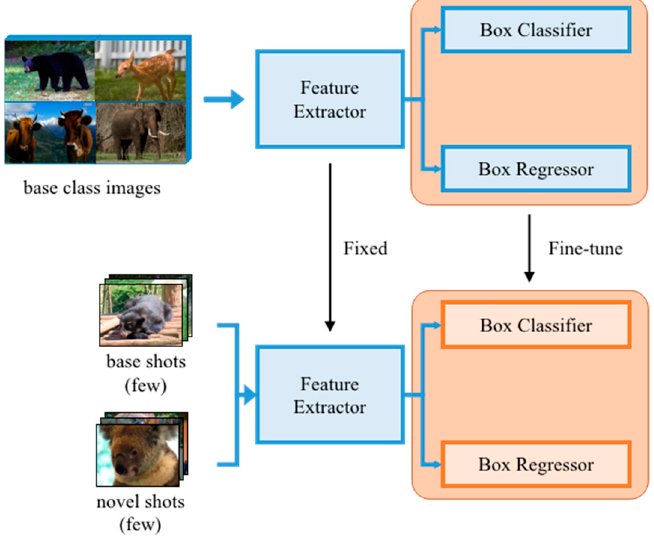
Figure 4. The proposed two-stage FSOD training strategy. In the base training stage, we apply abundant images to train the detector, including the feature extractor, box classifier, and box regressor. In the fine-tuning stage, the feature extractor is fixed, and we only select a few images to fine-tune the box classifier and box regressor.